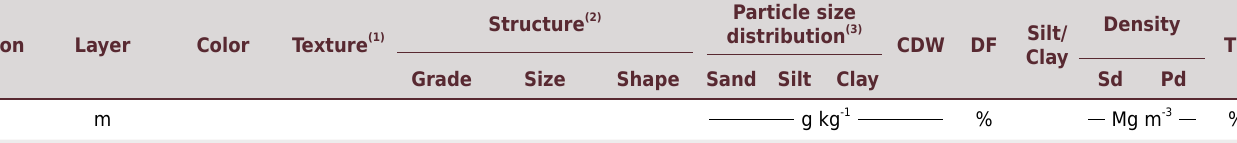
Table 1. Morphological and physical properties of soils in a rhyolite toposequence in the Ipojuca formation, Sirinhaém, PE, Brazil